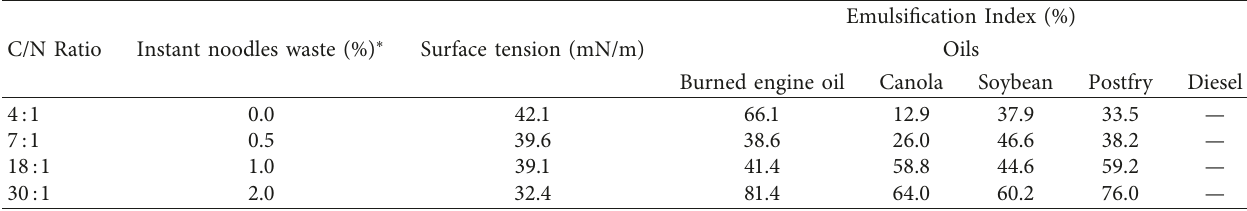
Table 2: Eco-friendly biosurfactant production by Cunninghamella echinulata related to C/N ratio on surface tension (ST) and Emul- sification Index (E24) evaluation.